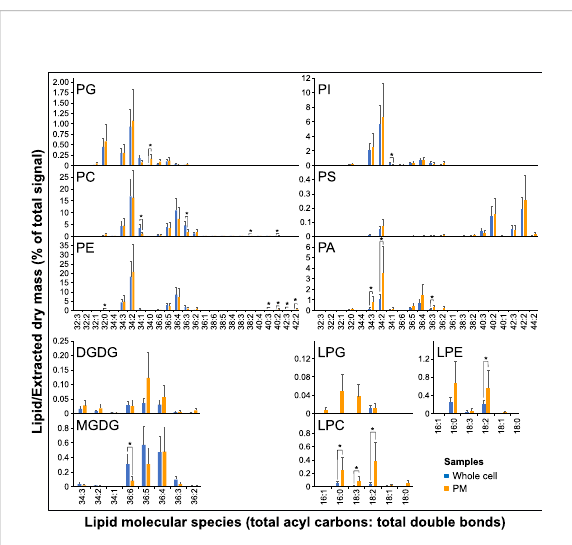
FIGURE 5 Changes in glycerolipid classes between PM-enriched fractions and corresponding whole cell samples. (A) The composition of the main lipid classes (DGDG, MGDG, PG, PC, LPG, LPC, LPE, PE, PI, PS and PA) for whole cell and PM samples. Data are presented as mean ± sd, n=5 (whole cell) and n=2 (PM). Asterisks (*), (**), (***) represent the signi fi cance between samples at p < 0.05, p < 0.01 and p < 0.001, respectively. (B) Total unsaturation index between PM and whole cell datasets. (C) Double bonds distribution between PM and whole cell